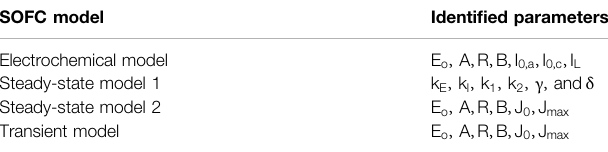
TABLE 1 | Summarization of identi fi cation parameters on various models. SOFC model Identi fi ed parameters Electrochemical model